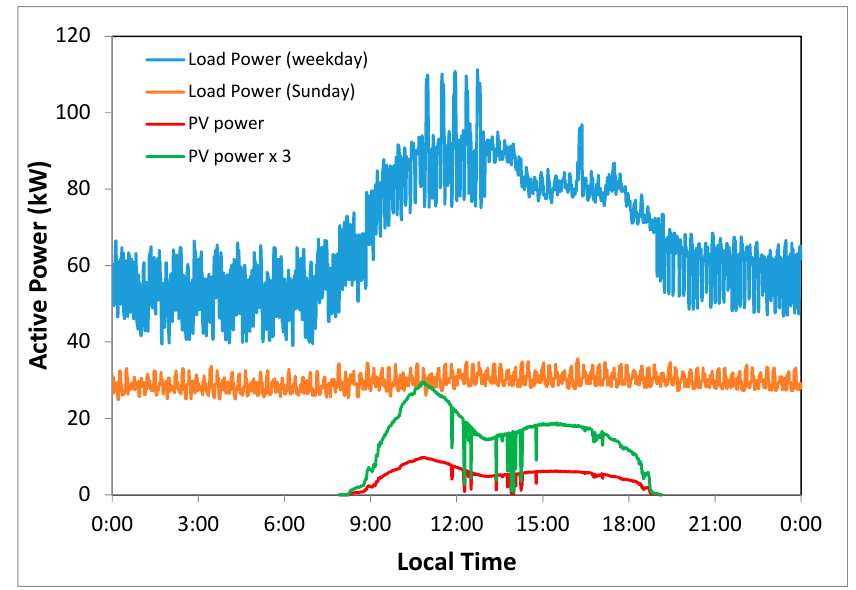
Figure 7. Example of CIEMAT Building 42 electric power consumption before the renovation, at a working day and a Sunday, and typical PV generation profile. In addition, a hypothetical case is included, keeping the same façades share but multiplying by 3 the installed power.